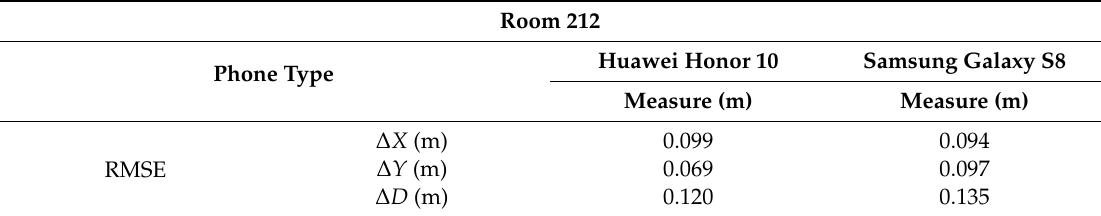
Table 3. Accuracy evaluation of positioning results in Room 212.